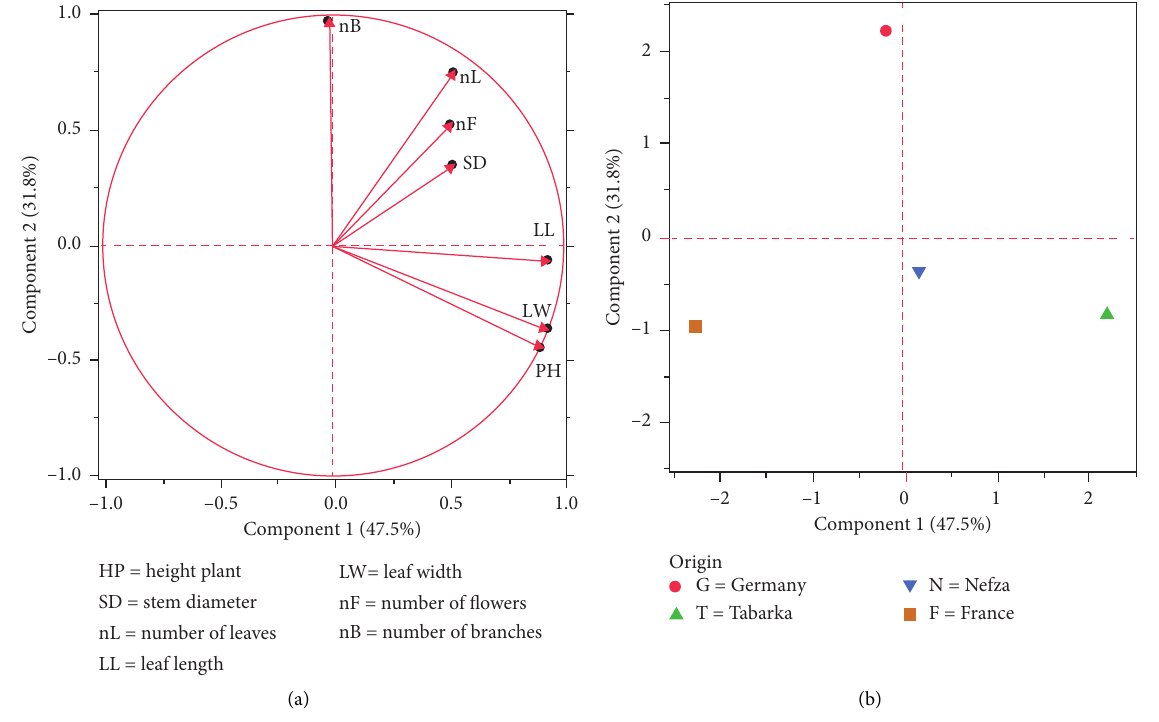
Figure 2: Plot of the first two principal components (C1 and C2) for the PCA of M. officinalis Table 4: Comparison of the essential oils isolated from different origins of M. officinalis .